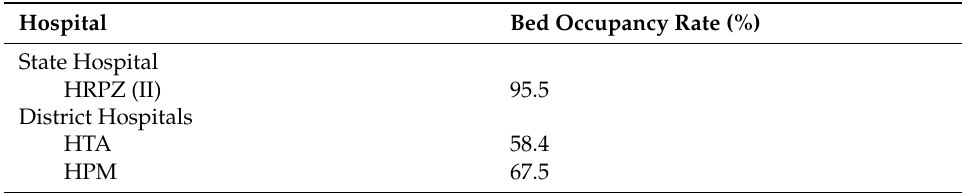
Table 3. Bed occupancy rates of the hospitals.